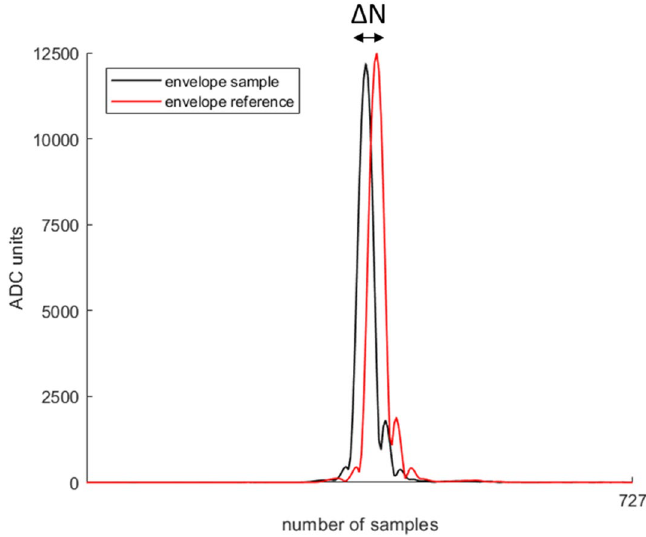
Figure 3. Example of signal envelopes for SoS measurement of Ag 2% samples. The envelopes of the signal in the presence of the sample (black line) and in the absence of the sample (red line) are shown in the figure for the central scanning